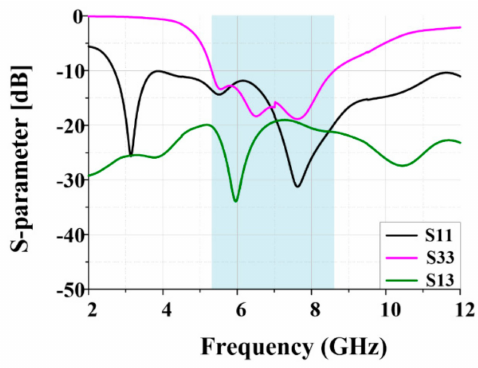
Figure 8. Simulated S-parameters of the proposed antennas for communication mode